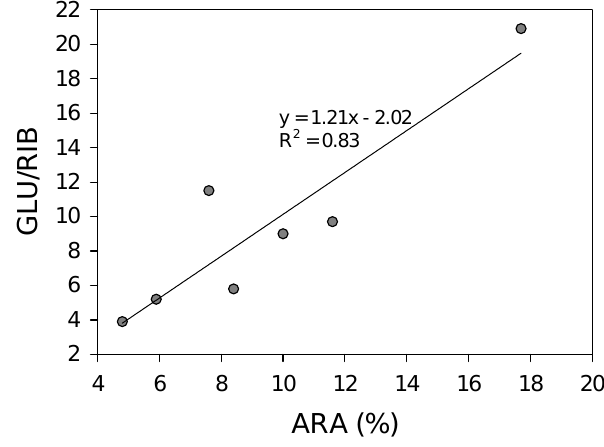
Fig. 8. wt % arabinose versus glucose/ribose ratio in the surface sediments collected from Lingdingyang Bay and the shelf of the South China